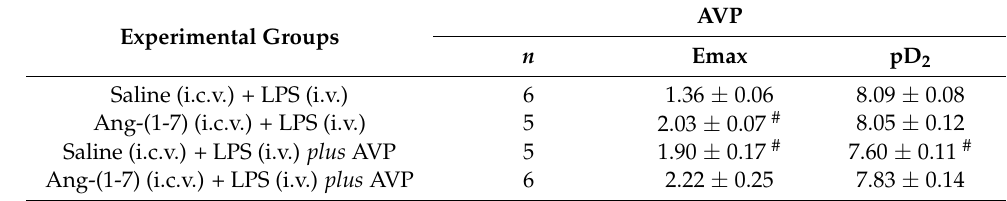
Table 4. Values of Emax and pD 2 obtained from concentration-response curves in response to NE, in the presence or absence of AVP (in vitro), in thoracic aorta rings of endotoxemic rats treated or not with Ang-(1-7).